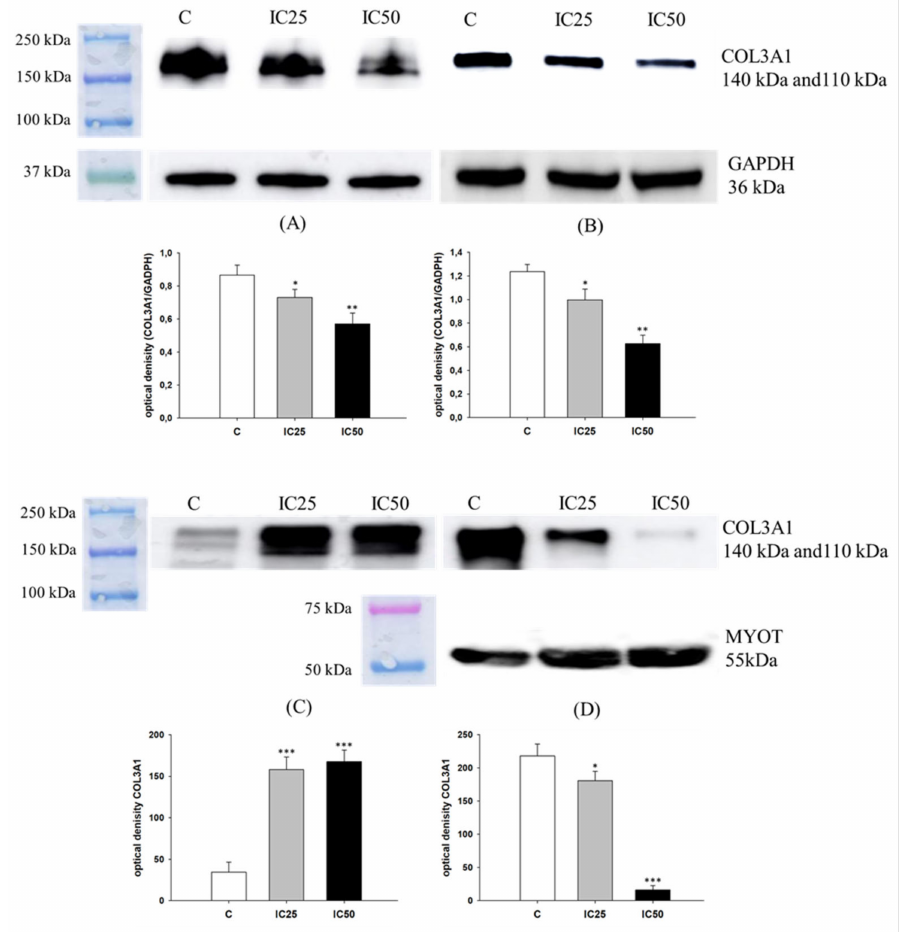
Figure 9. COL3A1 protein expression analysis in the W1PR2 ( A ) and W1TR cell lines ( B ) and their corresponding media ( C , D ), respectively. Protein lysates were prepared after 72 h of cell culture at piperine concentrations at the IC25 or IC50 along with the control untreated cells (C). Proteins were separated using 7% PAGE and transferred to a PVDF membrane, which was then immunoblotted with either primary Ab or HRP-conjugated secondary Ab. A primary anti-GADPH Ab was used as a loading control for the cell lysates. MYOT was used as a loading control for medium from W1TR cell line. The graphs show the results of the densitometry quantification of the Western blot analysis optical density, which is presented as a COL3A1/GADPH ratio ( A , B ) or COL3A1 optical density ( C , D ). The values were considered significant at * p < 0.05 and ** p < 0.01, *** p <